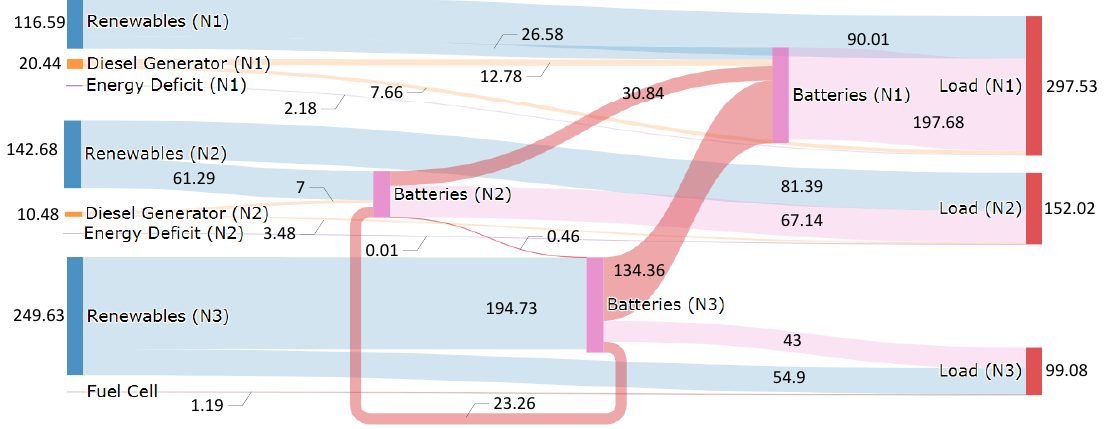
Figure 21. Total energy flow (kWh) in the microgrid with the NMPC enabled in weekly operation.